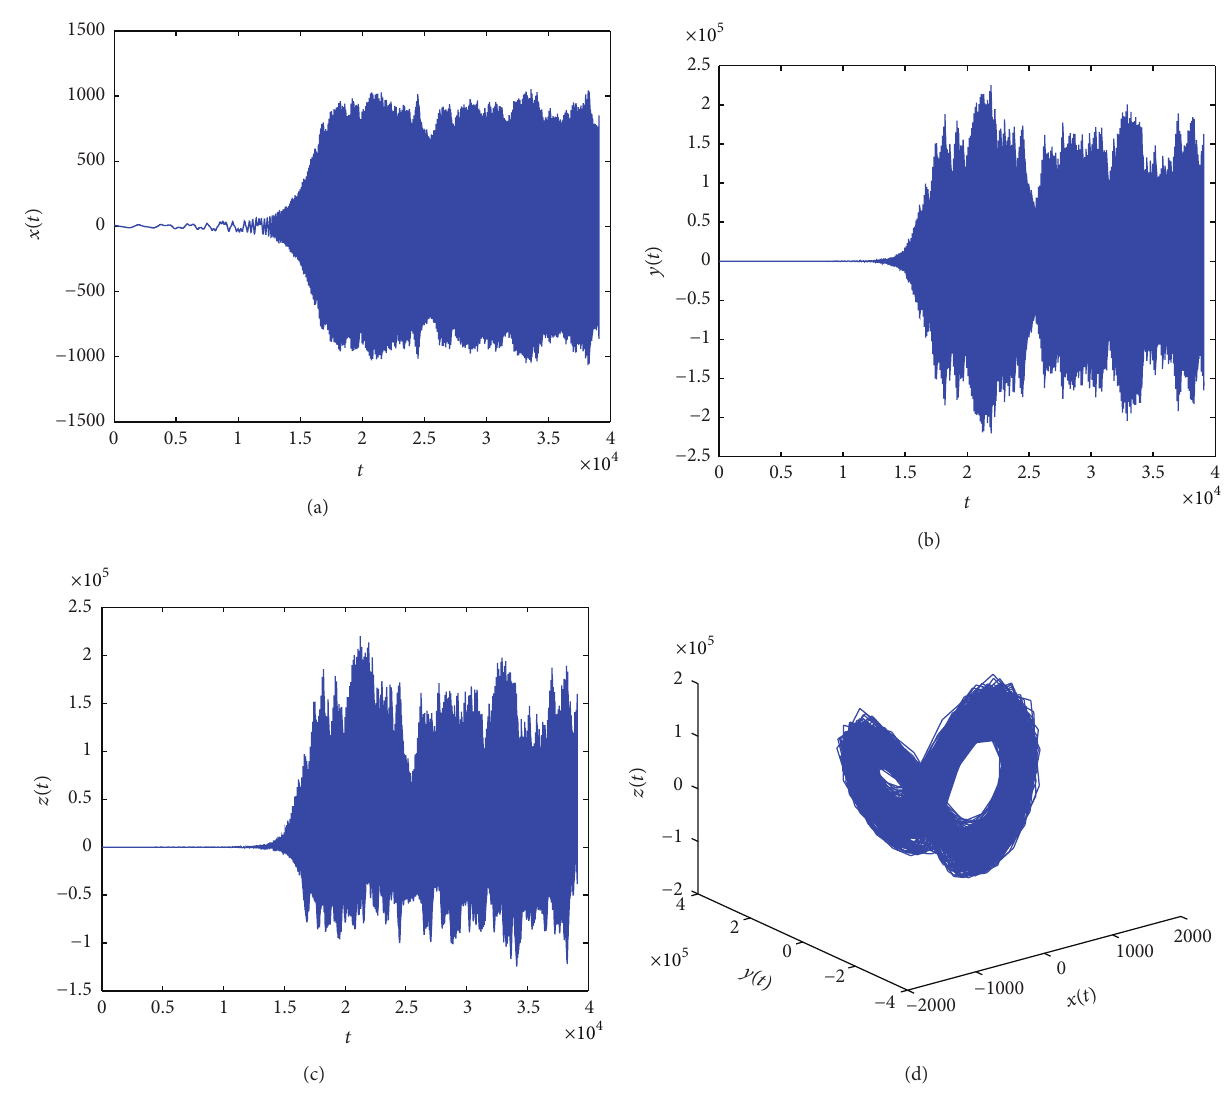
Figure 3: The trajectories and the phase graph of system (83) with 𝑇 = 98 , 𝜀 = 0.326 , and 𝜏 = 0.4 ; 𝐸 ∗ 2 is unstable, and a rank one strange attractor